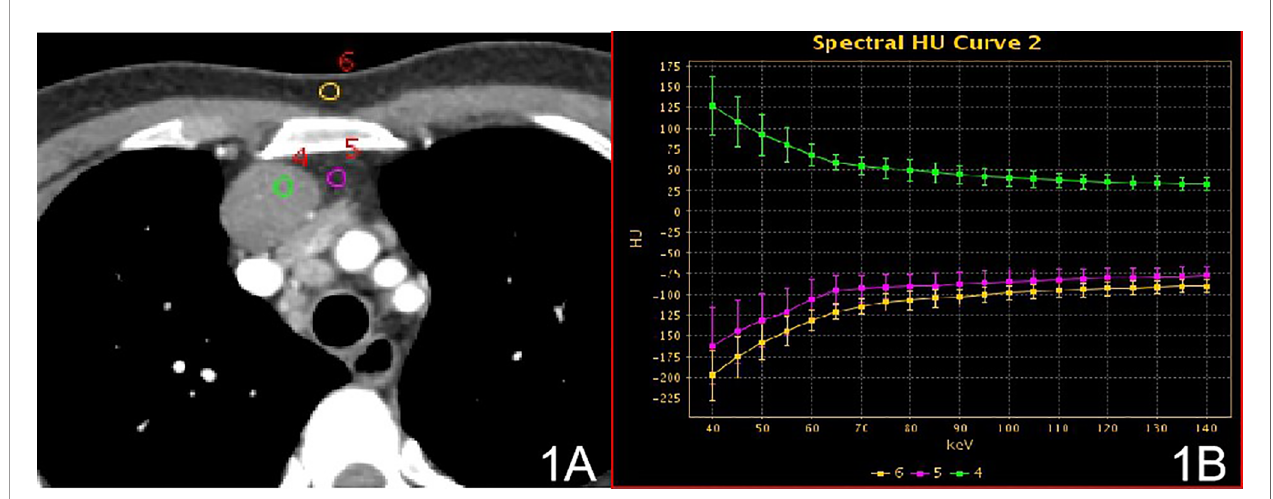
FIGURE 1 | Stage I, (A) 70 keV single-energy CT value of the arterial phase is used to outline the ROI of the lesion; (B) spectrum of arterial lesions (green), spectrum of fat outside the lesion (purple) and spectrum of anterior chest wall fat (yellow).